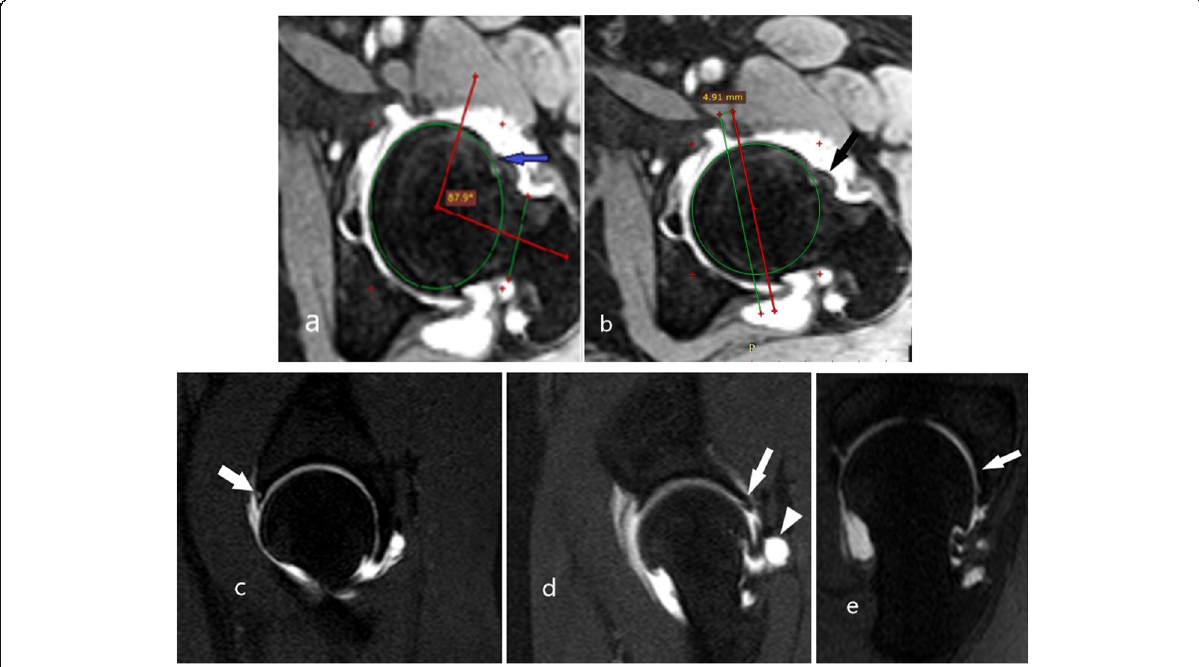
Fig. 4 Femoroacetabular impingement (cam type) in a 25-year-old male patient, complaining of left hip pain and limitation of movement. a , b Axial oblique T1 fat sat post-contrast: a increased alpha angle (87.9°) and abnormal bone bump at the head – neck junction (arrow),